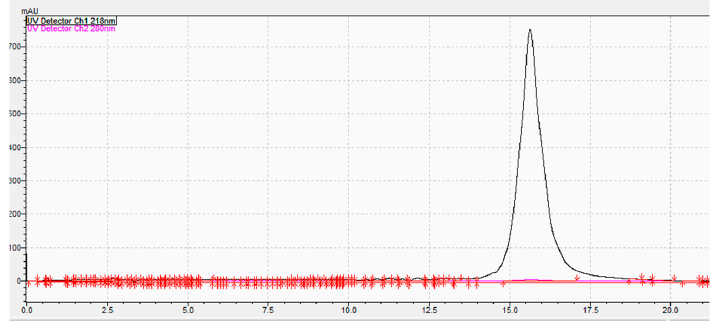
Figure 9. Reverse phase high-performance liquid chromatography (RP-HPLC) spectrum of piscine gelatine.